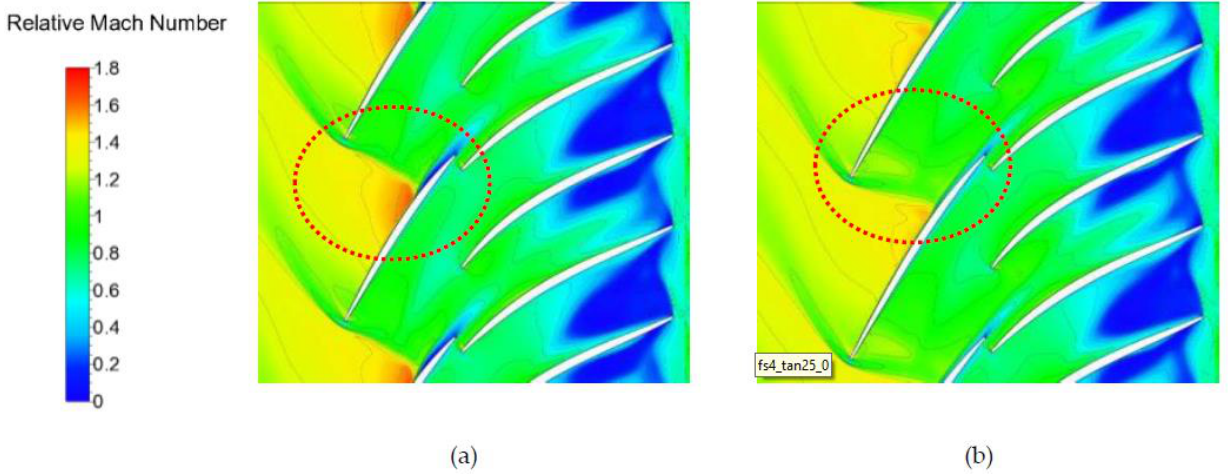
Figure 24. Comparison of the relative Mach number at a 95% span for different tandem impellers (P.E. point). ( a ) Baseline tandem impeller, and ( b ) tandem impeller with a forward sweep (F = 4 mm).